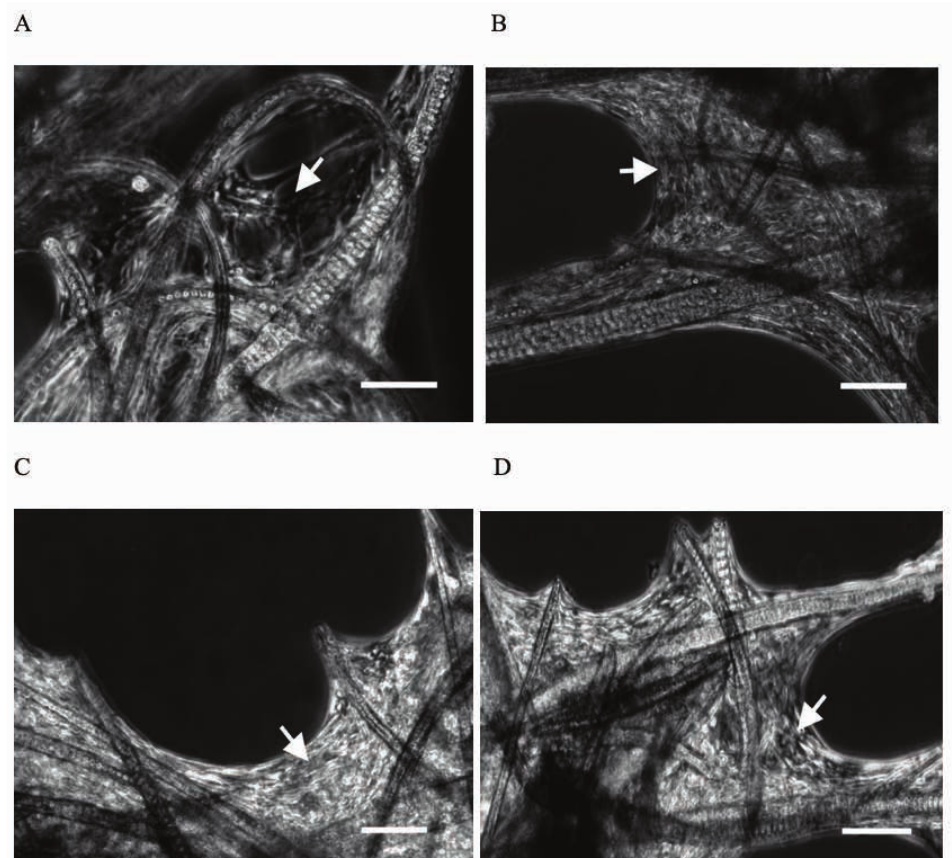
Figure 3: Light microscopic observation of cell growing (rMSC) on F-KAPs. (A) 14 days culturing, (B) 21 days culturing, (C) and (D) 32 days culturing, arrow shows rat mesenchymal stem cells, scale bar = 200 μ